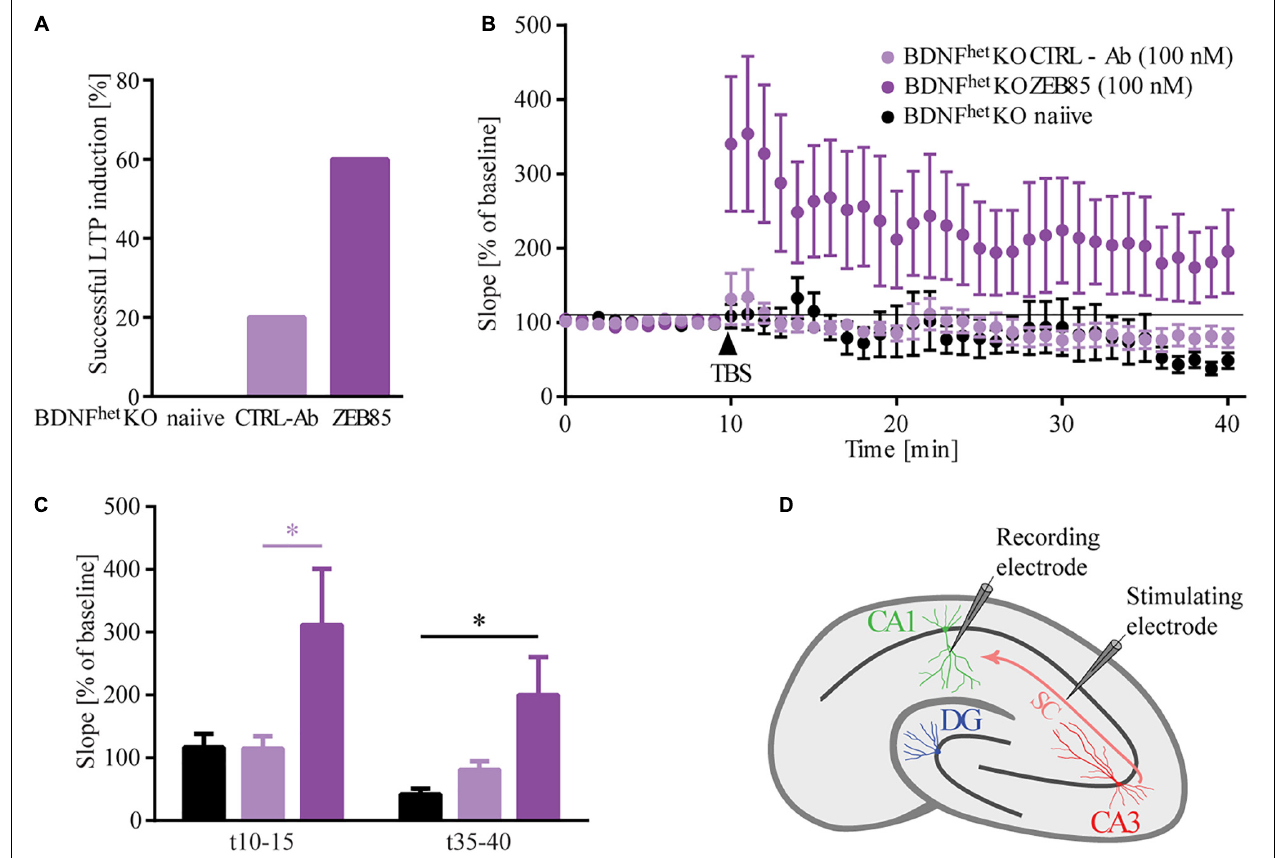
FIGURE 5 | ZEB85 rescues LTP deficits in hippocampal slices of BDNF knockout mice. fEPSP were recorded at the CA3-CA1 pathway of DIV21/22 organotypic hippocampal slice cultures prepared from heterozygous BDNF-knockout mice treated for 5–6 days with 100 nM ZEB85 or CTRL-Ab or left untreated. (A) Graph shows the percentage of successful LTP inductions. The criterion for a successful LTP induction was based on the fact that fEPSPs for the last 5 min after TBS were larger than 120% of the baseline. (B) fEPSP recordings over time. Baseline was recorded for 10 min after which TBS was applied and LTP was measured for another 30 min. The data are presented as mean ± SEM and were tested using a repeated measure two-way ANOVA. (C) Graph shows the mean values of the first and last 5 min after LTP induction. The data are presented as mean ± SEM and were tested using a one-way ANOVA with Bonferroni post-test. (D) Schematic of the fEPSP recordings in a hippocampal slice with electrode placement in the CA3-CA1 pathway. (Naïve: N = 5 mice, n = 8 slices; CTRL-Ab and ZEB85: N = 6 mice, n = 10 slices). ∗ p <